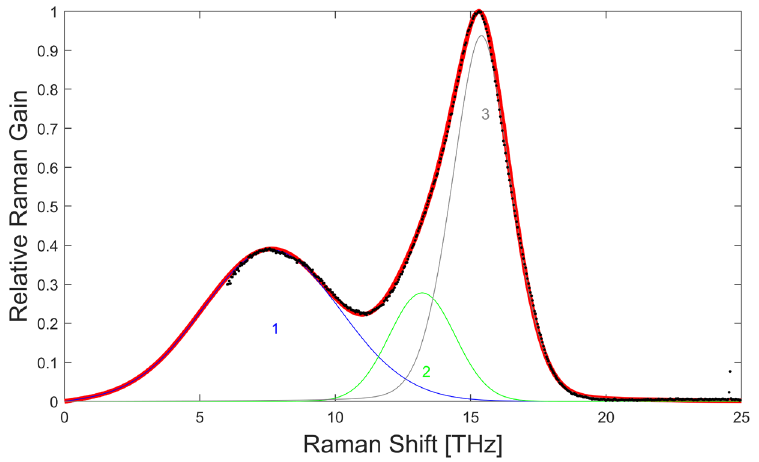
Figure 15. Relative Raman gain in InF 3 fiber: measurements (black dots) and curve fit (red) corresponding to the sum of 3 pseudo-Voigt profiles (blue, green, gray). An extrapolation toward small frequencies was required in the